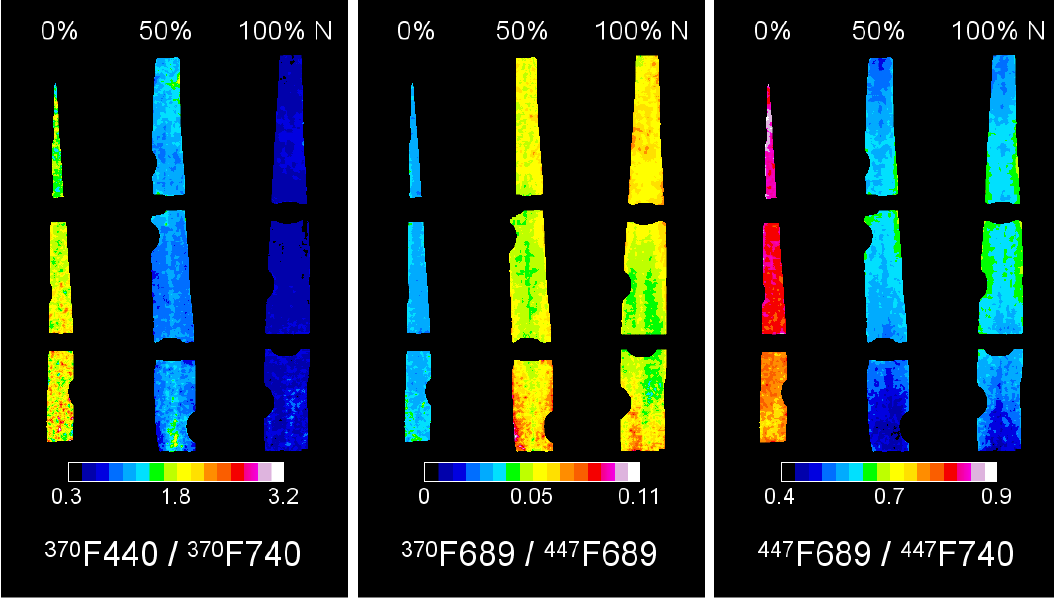
Figure 4. Fluorescence images of barley leaves ( Hordeum vulgare L.) grown under different nitrogen supply expressed as ratios of two different fluorescence bands (see Table 2 for the values). Each ratio (panel) shows the same representative leaf at the level of 0%, 50%, and 100% nitrogen (left to the right). The fluorescence ratio images are shown in false colors.